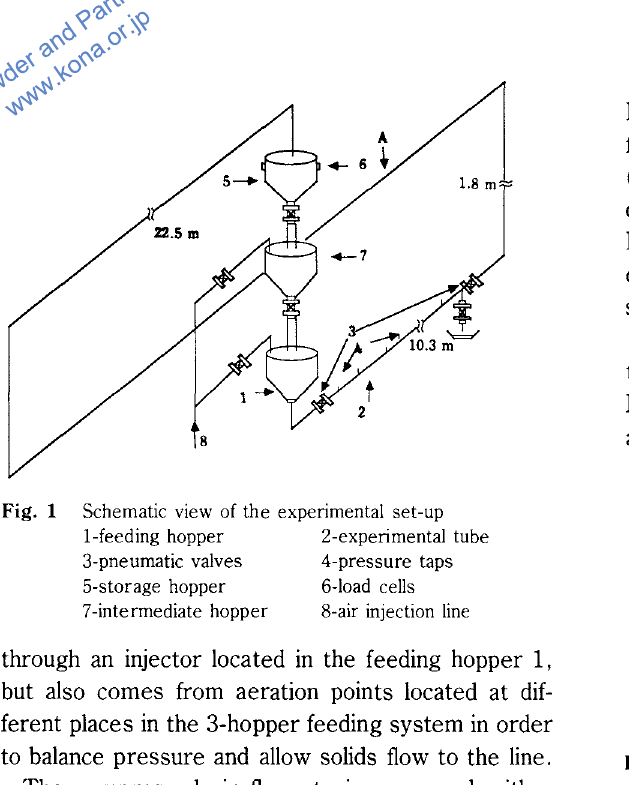
Fig. 3 Signals used for measurement of front (back) plug velocity